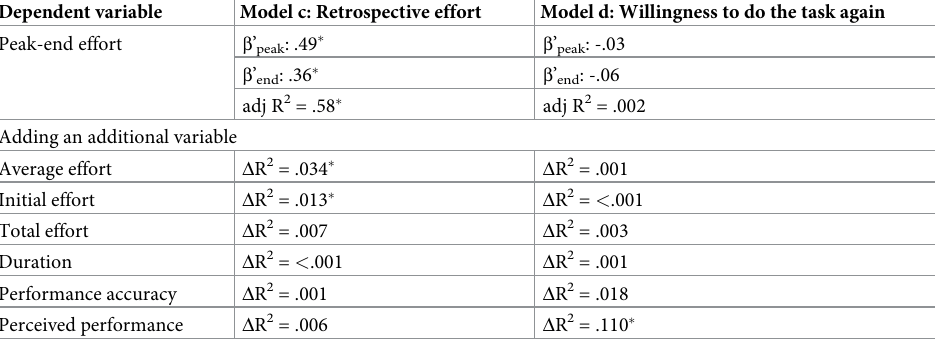
Table 5. Hierarchical regression analysis predicting retrospective effort and the willingness to do the task again from real-time ratings of